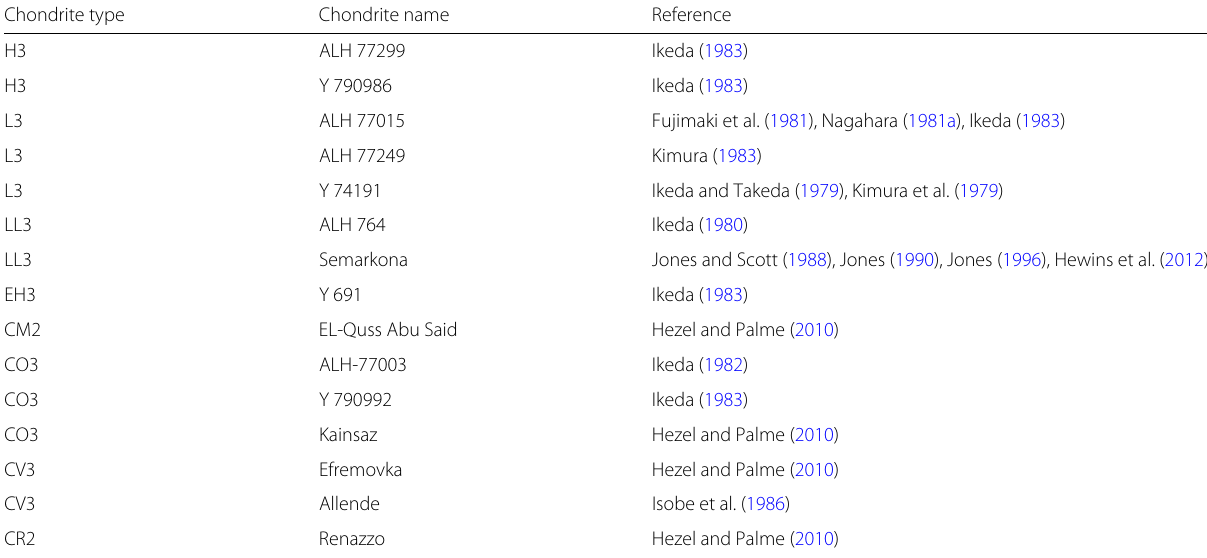
Table 8 Data source of chondrule compositions Chondrite